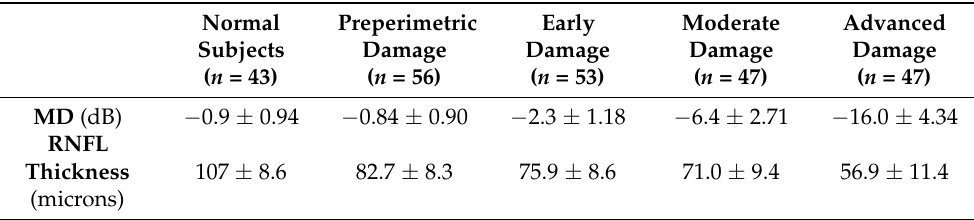
Table 1. Mean MD value and average RNFL thickness in normal subject and in the four groups of patients considered for validation of the GGSS.